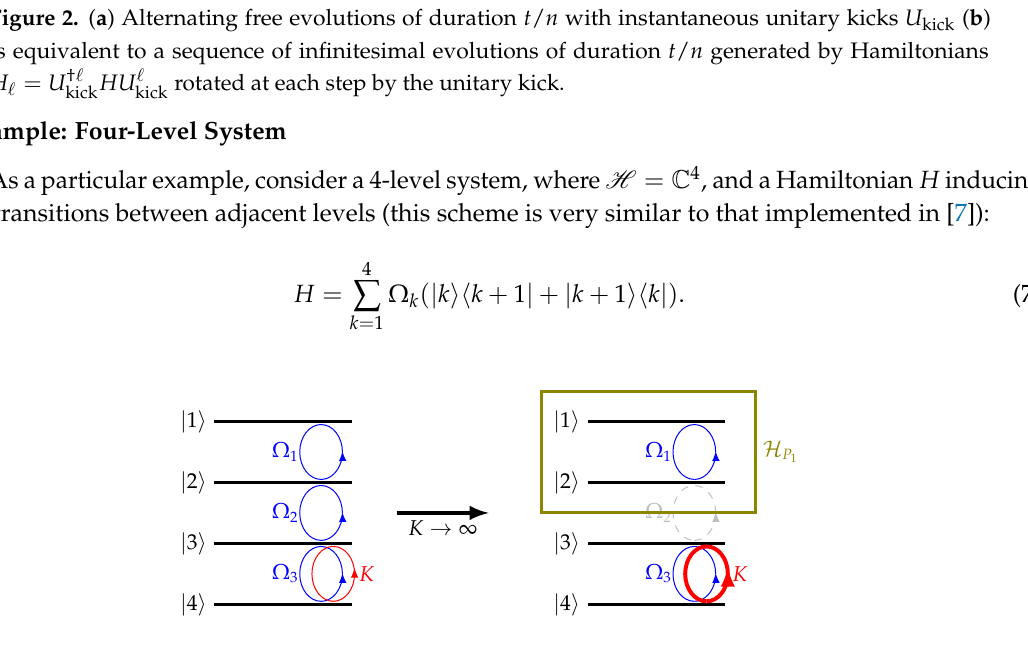
Figure 3. Effect of the strong coupling between states | 3 (cid:105) and | 4 (cid:105) . The other two QZSs have not been highlighted in the figure since they are made of linear combinations of states | 3 (cid:105) and | 4 (cid:105)